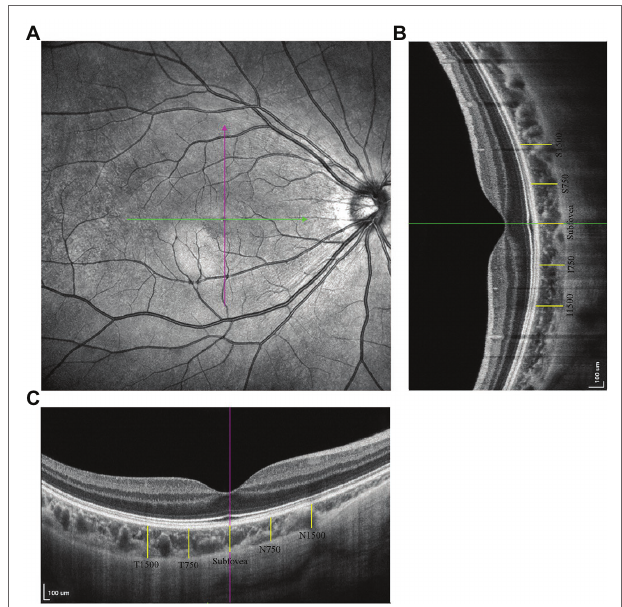
FIGURE 1 | The measurements of choroidal thickness (CT). (A) The horizontal and vertical scan line centering on the fovea. (B) The choroidal thickness measurements in vertical scan. (C) The choroidal thickness measurements in horizontal